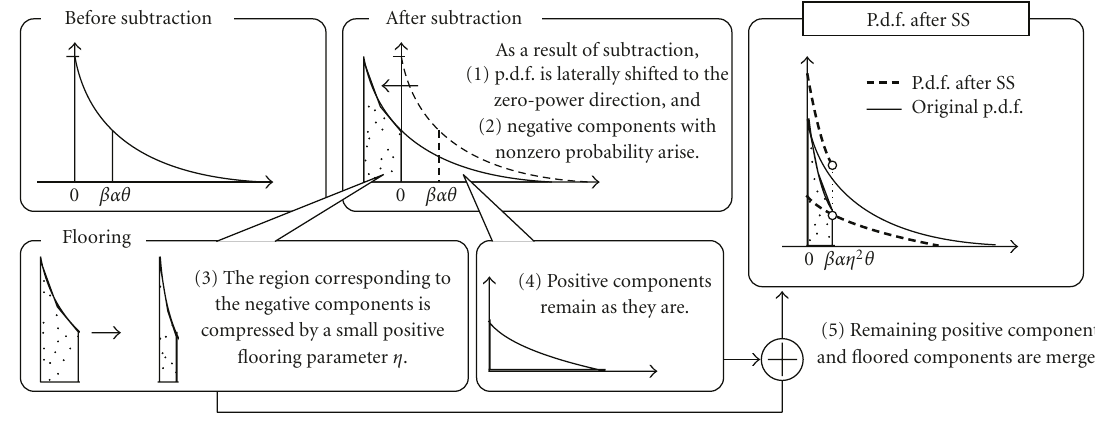
Figure 5: Deformation of original p.d.f. of power-domain signal via